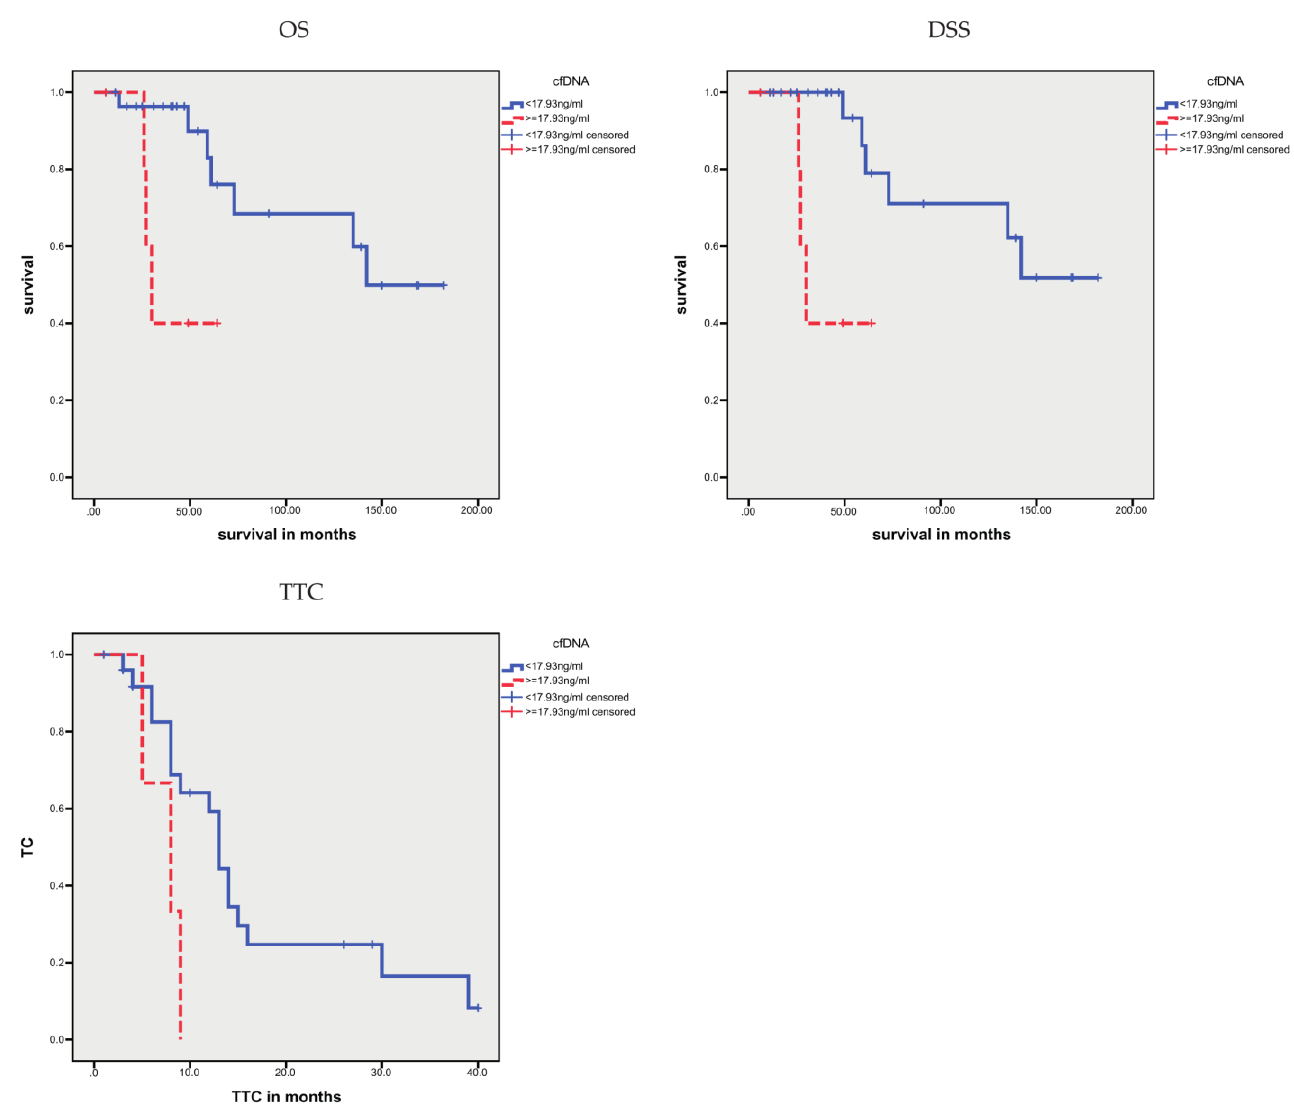
Figure 2. Kaplan–Meier analysis: association between cfDNA concentration and prognosis (OS, DSS, and TTC). A higher cfDNA concentration (> 17.93 ng/mL) was associated with a shorter OS ( p = 0.014), DSS ( p = 0.004), and TTC ( p = 0.001). Table 5. Univariate Cox’s regression analysis: association of cfDNA levels, CTCs, or AR-V7-positive CTCs with prognosis. Table 4. Kaplan – Meier analysis: association of cfDNA levels, CTCs, or AR-V7-positive CTCs with prognosis. Parameter